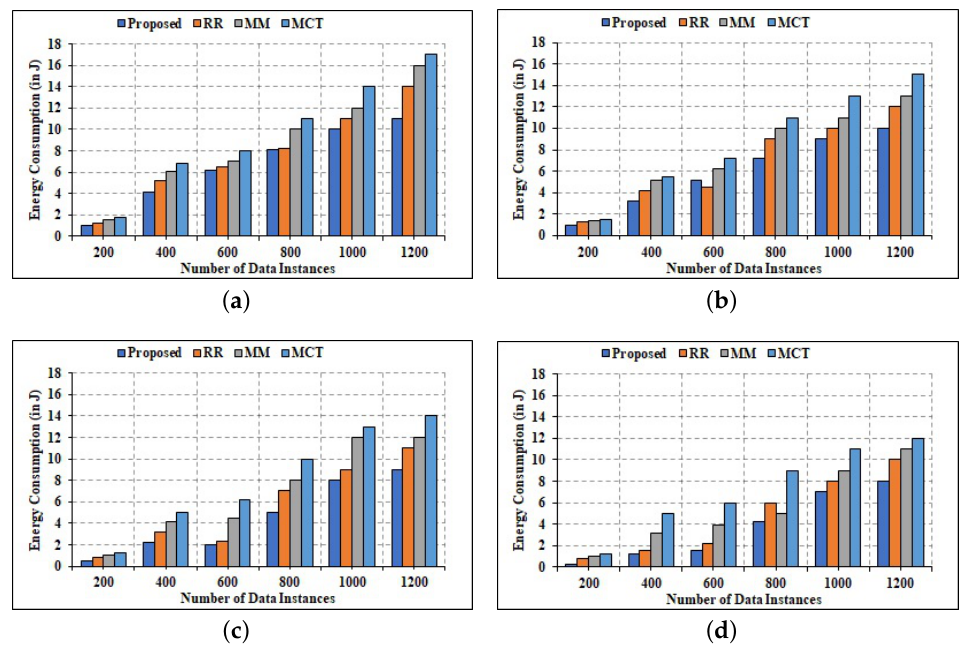
Figure 12. Comparative Analysis of Energy Efficiency. ( a ) 6 Edge Nodes; ( b ) 10 Edge Nodes; ( c ) 14 Edge Nodes; ( d ) 20 Edge